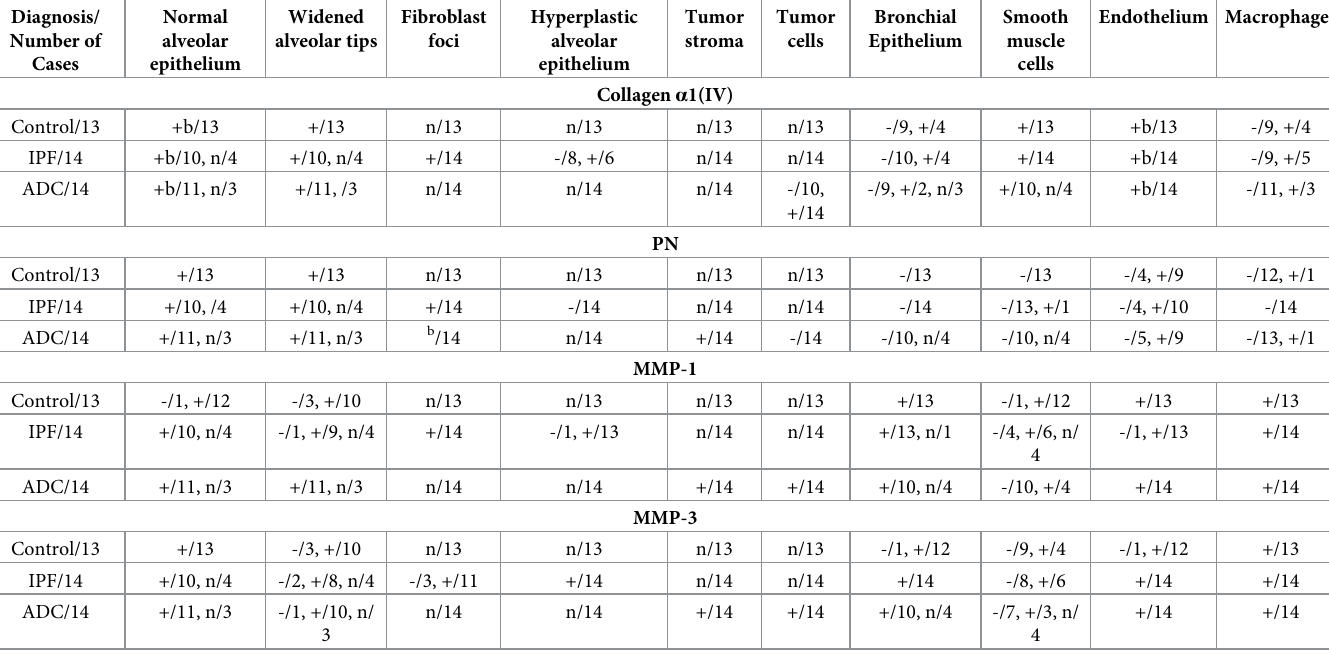
ADC, adenocarcinoma; b, immunoreactivity in basement membrane; IPF, idiopathic pulmonary fibrosis; MMP, matrix metalloproteinase; n, structure not present; PN, periostin; -, negative immunoreactivity; +, positive immunoreactivity. � Score/number of